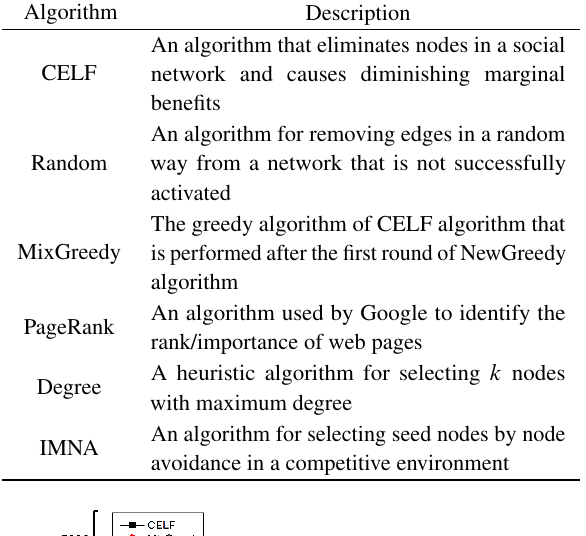
Table 1 Comparison algorithms and descriptions in the experiment.